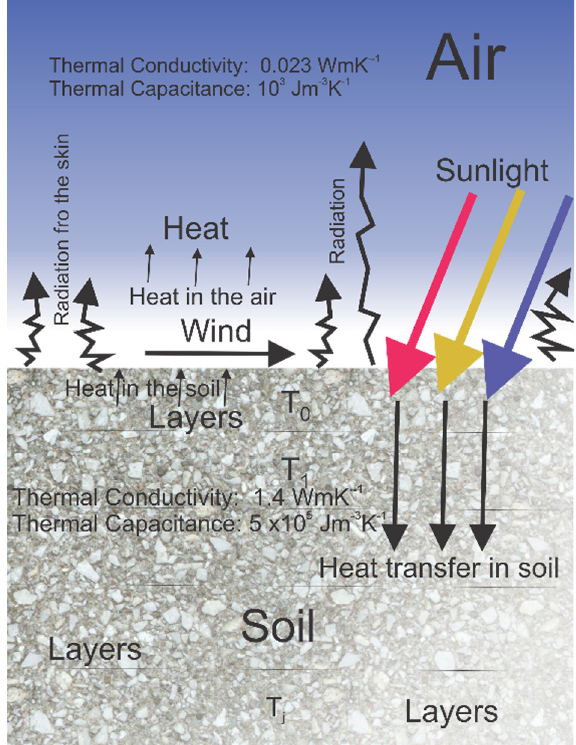
Fig. 1. Energy from the visible sunlight absorbed by the planet’s surface raising the temperature of the soil below as the heat is transmitted to lower levels. The air above is also warmed through the contact with the hot surface skin , which also emits energy to space as infrared